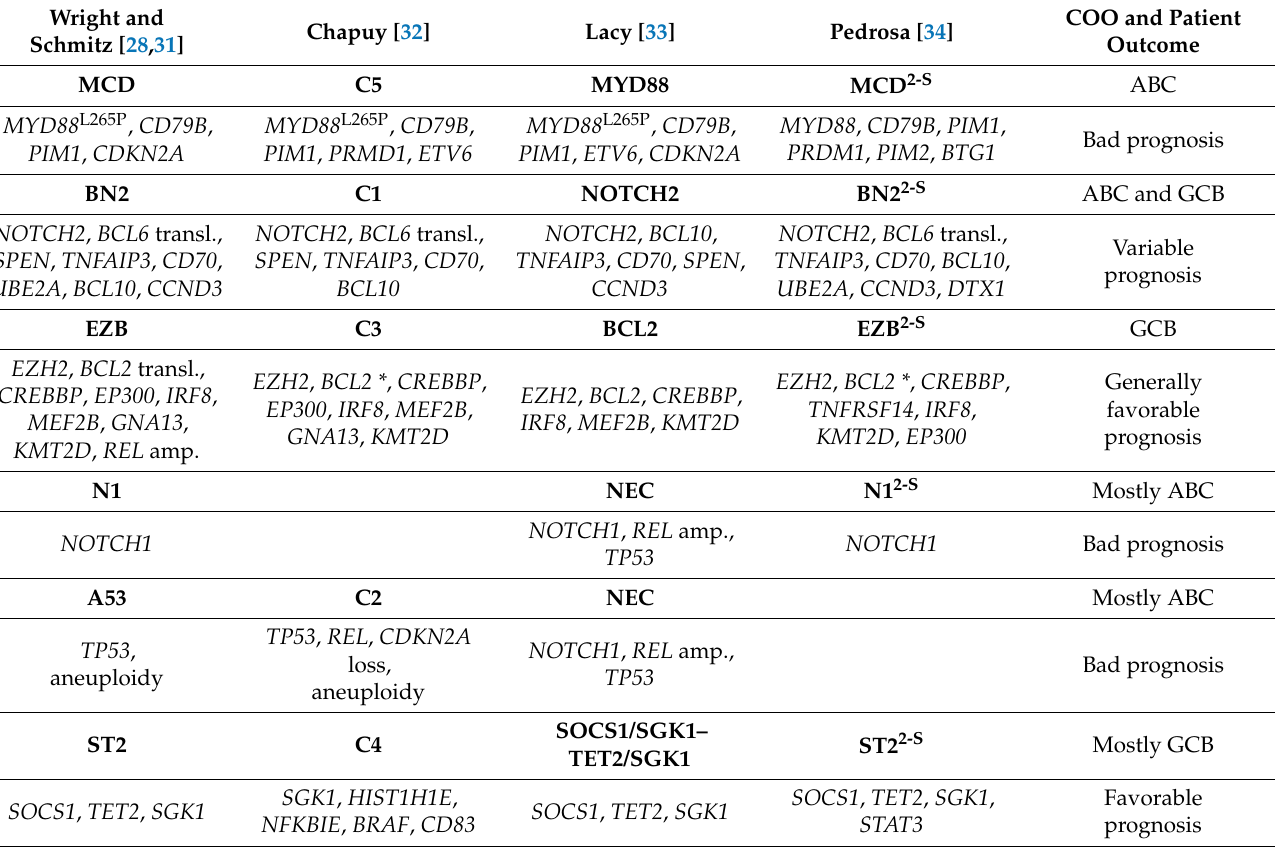
Table 1. DLBCL genomics: the genetic signature helps predict patient outcome. Comparison of the newly proposed genetic subtypes in DLBCL. The names of the genetic subtypes proposed by each group are highlighted in bold. COO: cell of origin; ABC: activated B-cell like; GCB: germinal center B-cell like; amp: amplification; transl: